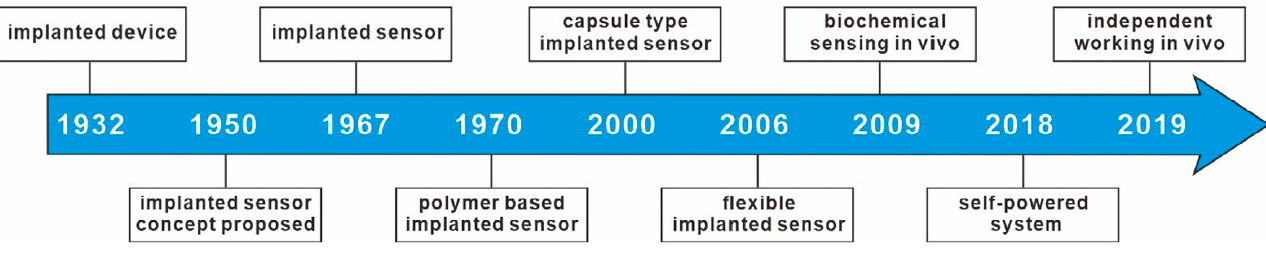
Figure 1. Timeline of implantable sensors developments. Reproduced with permission from ref.